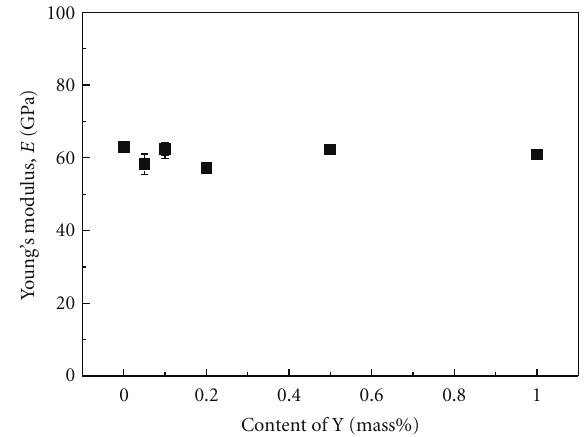
Figure 8: Young’s modulus as a function of Y concentration in TNTZ-Y CR